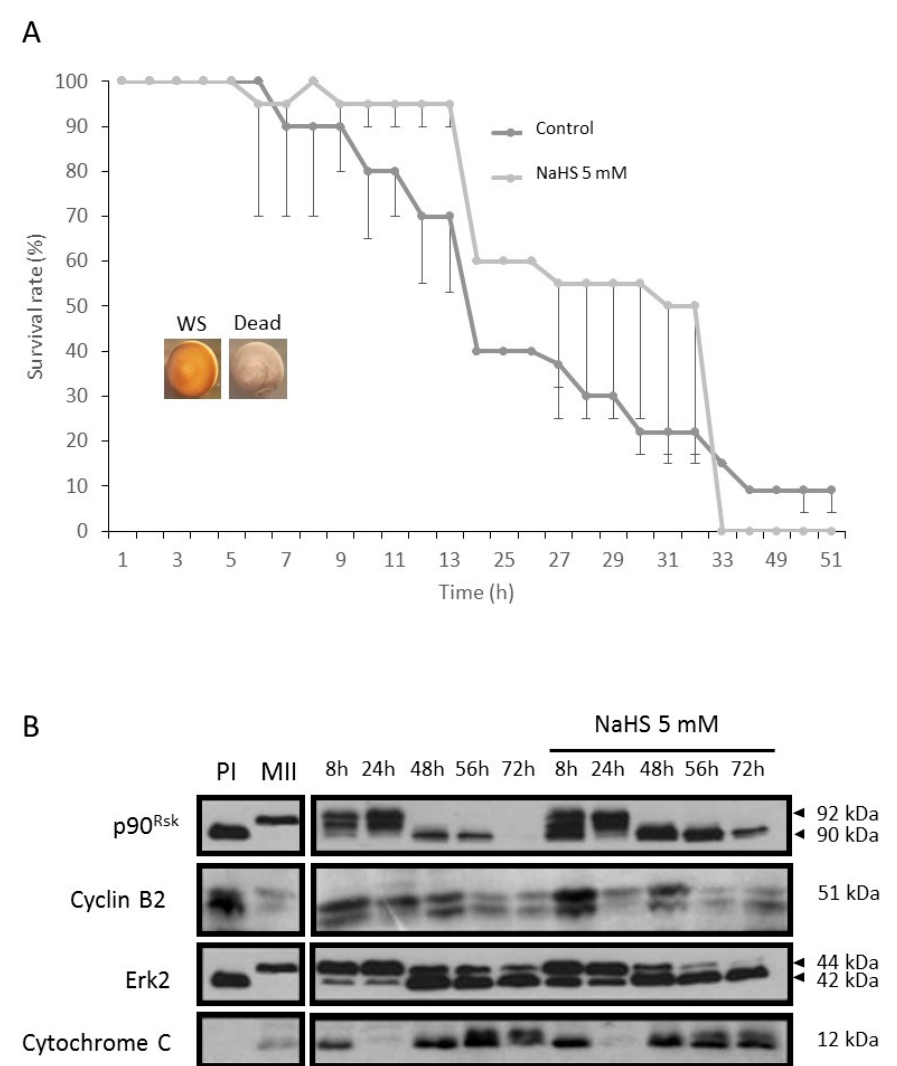
Figure 9. NaHS has no effect on apoptosis in Xenopus oocytes. ( A ) Survival rates of mature (WS) oocytes in presence or absence (control) of NaHS at the concentration of 5 mM. The number of dead oocytes was determined every hour. Microphotographs of healthy (WS) or dead (Dead) oocytes are shown. ( B ) Western blot of p90 Rsk , Erk2, cyclin B2, and cytochrome C. Mature oocytes were incubated (or not) in NaHS at 5 mM for 8, 24, 48, 56, and 72 h. Some oocytes were maintained in culture medium without treatment (PI) or in progesterone (4 μ g/mL) alone (MII).